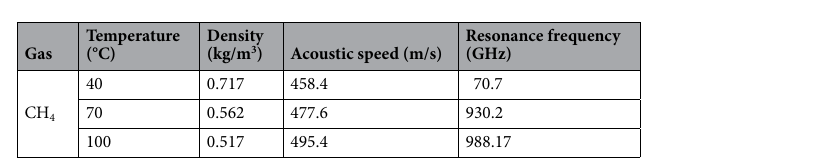
Figure 6. Illustrates the temperature effect on the ( a ) Fano resonance peak position of FC(7, 1) quasi-periodic gas sensor towards CH 4 gas ( b ) change of CH 4 gas acoustic properties with different temperatures.